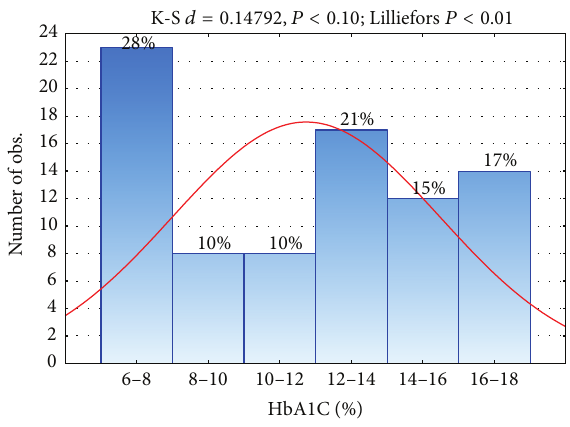
Figure 1: Distribution (%) of HbA1c in children and